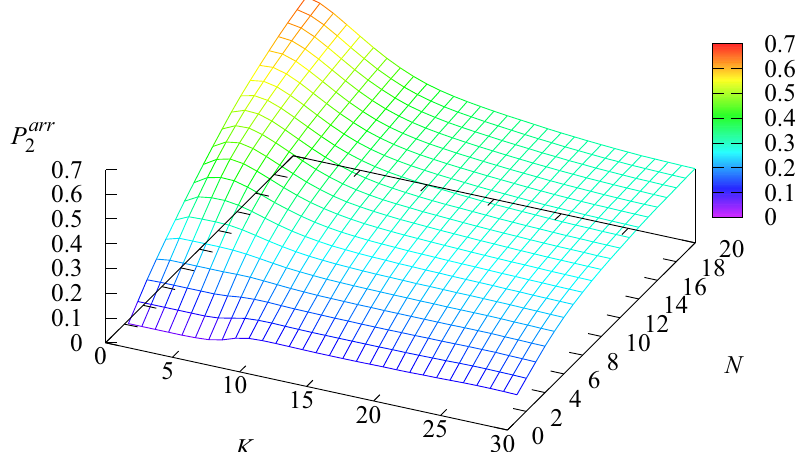
Figure 7. Dependence of the probability P arr the parameters N and K .